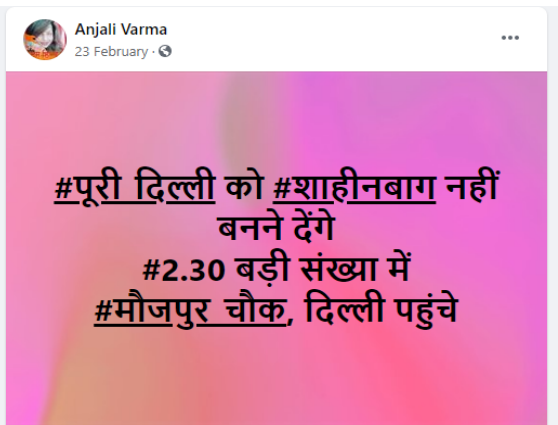
Figure 4. Facebook post on 23 February inviting people to assemble in northeast Delhi. “We will not let the entire Delhi turn into #ShaheenBagh. Reach #MaujpurChowk #2.30 pm in big numbers”.